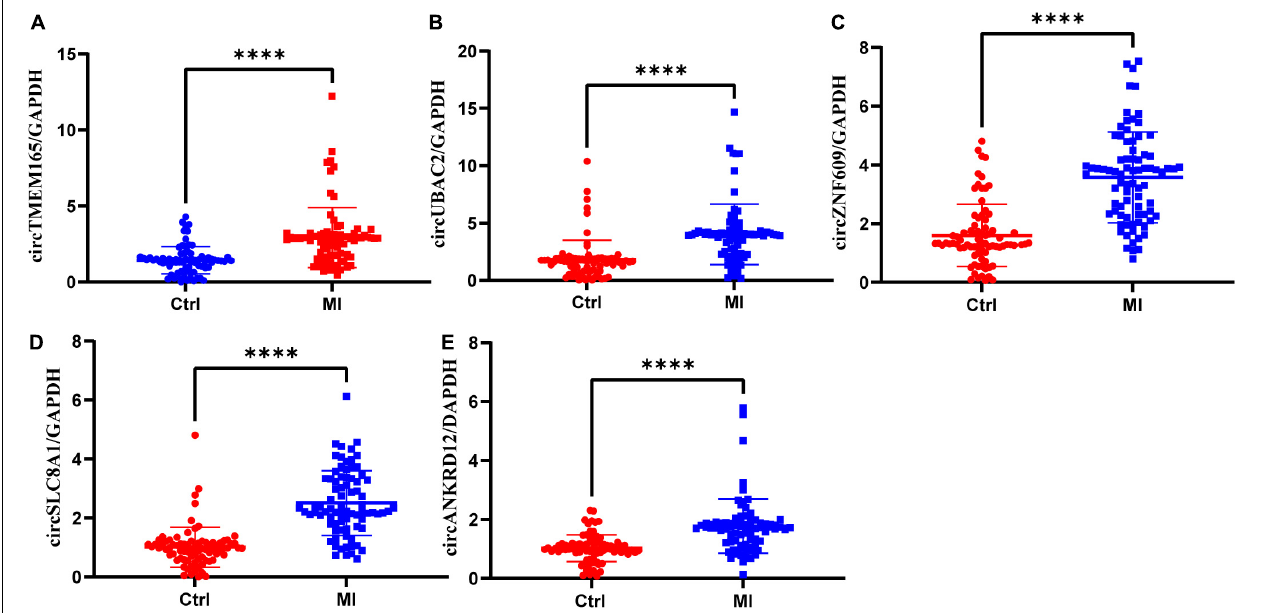
FIGURE 3 | Validation of differentially expressed circRNAs. RT-qPCR validation of selected circRNAs. (A–E) The relative expression levels of circRNAs in peripheral blood MI patients and controls (Ctrl: healthy controls; MI: myocardial infarction patients; ∗∗∗ P < 0.0001).